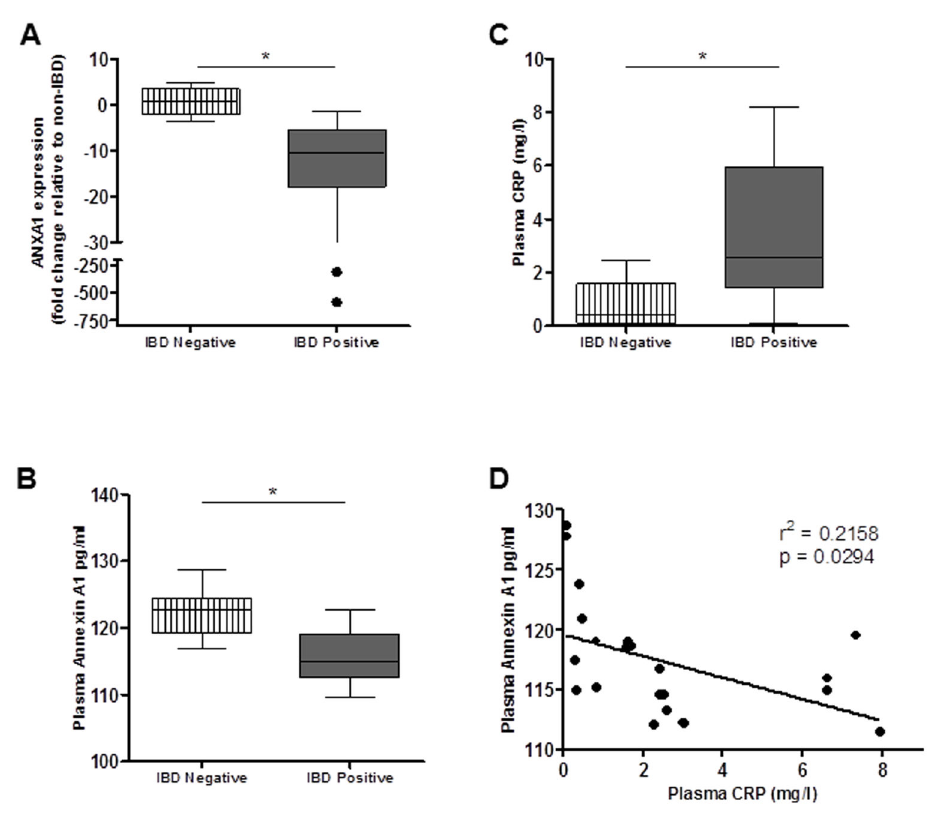
Figure 2. ANXA1 is expressed at lower levels in blood of IBD patients. (A) The level of ANXA1 mRNA was determined by real- time RT-PCR analysis from peripheral blood mononuclear cells was lower in IBD patients compared to healthy controls. (B) Plasma Annexin A1 levels were assayed using ELISA. Patients with IBD had lower levels of plasma ANXA1 compared to IBD negative controls. (C) Plasma CRP levels were measured by ELISA. Healthy controls had significantly lower levels of plasma CRP compared to patients with IBD. An inverse correlation was observed between plasma CRP and plasma ANXA1 (D). (*p <